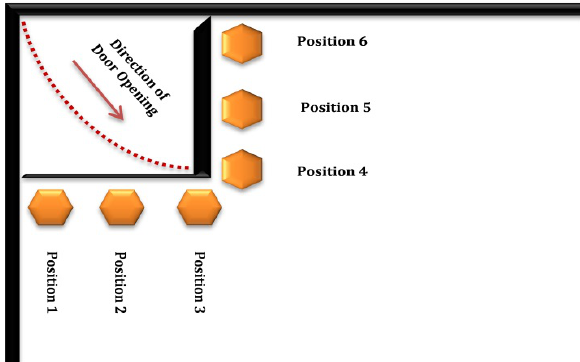
Figure 3: Division of the door region into